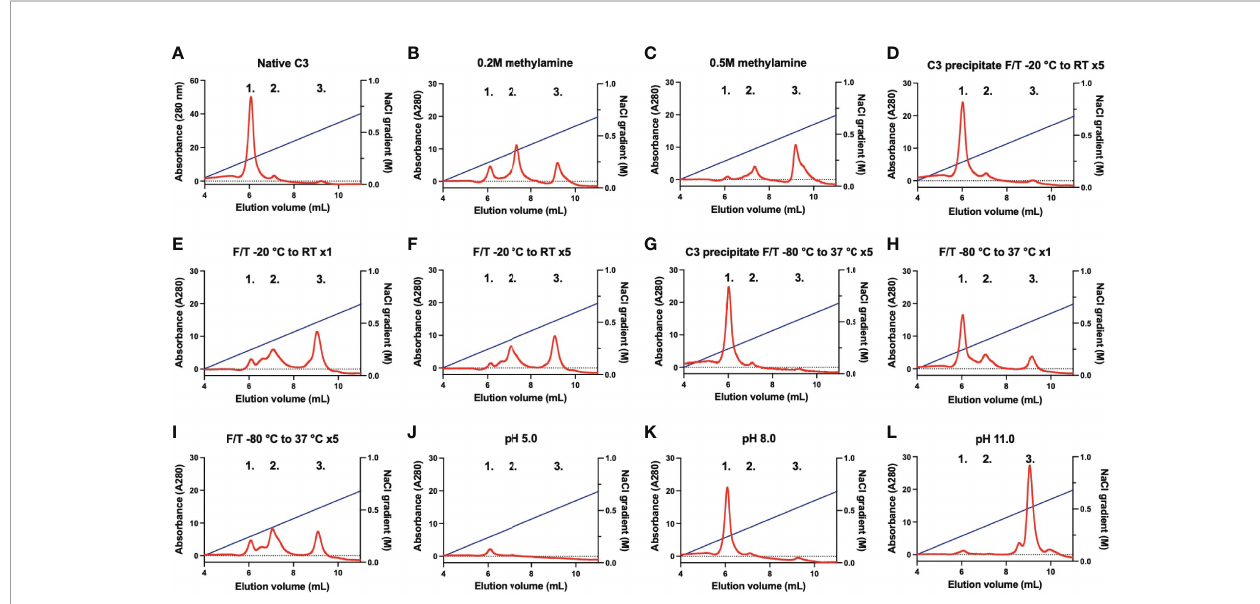
FIGURE 1 | Representative chromatograms of different C3 samples analyzed on a Mono S column eluted with a gradient of 0-0.85 M NaCl. Peak 1 ; native C3, peak 2 ; C3(H 2 O) intermediate, and peak 3 ; C3(H 2 O). (A) native C3, (B) native C3 treated with 0.2 M methylamine, (C) native C3 treated with 0.5 M methylamine, (D) C3 in precipitated form F/T fi ve times from -20°C to RT, (E) native C3 stored frozen once at -20°C (F) native C3 F/T fi ve times from -20°C to RT, (G) C3 in precipitated form F/T fi ve times from -80°C to 37°C, (H) native C3 frozen once at -80°C, (I) native C3 F/T fi ve times from -80°C to 37°C, (J) native C3 treated at pH 5.0, (K) native C3 treated at pH 8.0 and (L) C3 treated at pH 11.0. F/T, freeze/thaw; RT, room